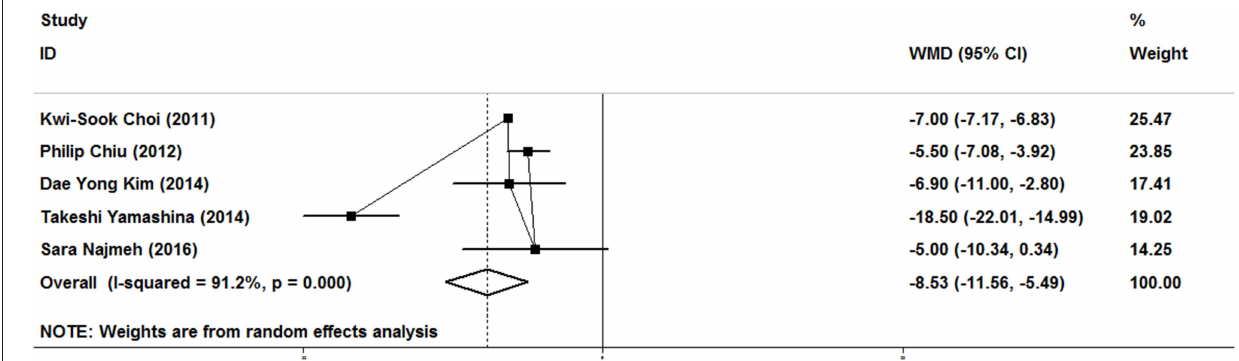
FIGURE 2 | Meta-analysis on length of stay, there was significant difference in length of stay between the ER and gastrectomy treatments.